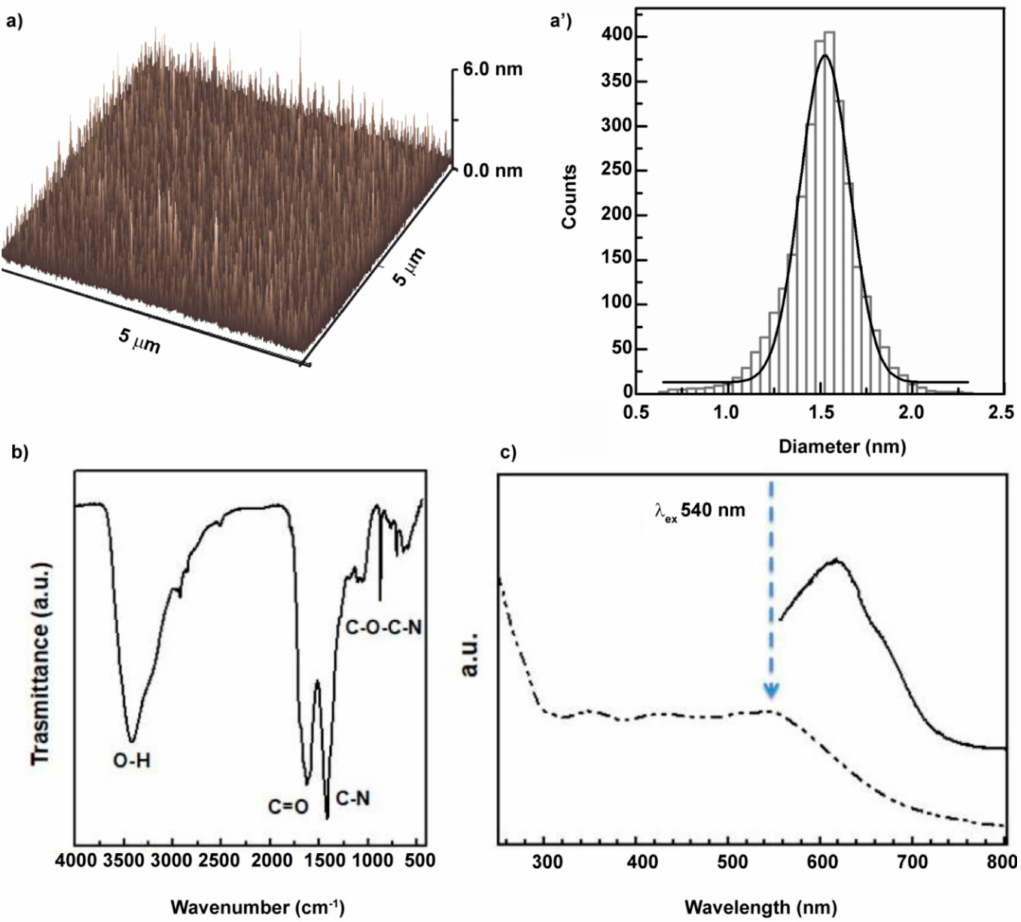
Figure 1. Chemical and physicochemical characterization of CDs. Size distribution of CDs by atomic force microscopy ( a , a’ ). Surface characterization by FTIR analysis ( b ). Absorption UV / vis spectrum and emission spectra exited at 540 nm of aqueous dispersion of CDs ( c